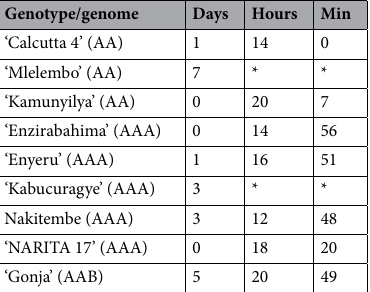
Table 2. Duration between female and male flowers opening. *Precise time could not be computed.